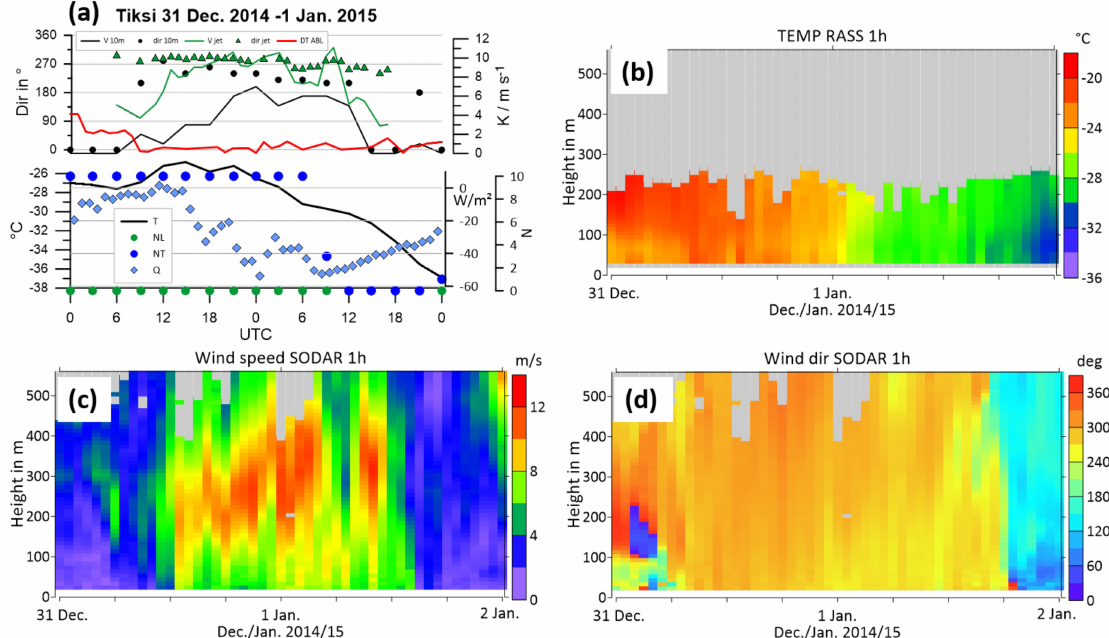
Figure 13. ( a ) Observations for 31 December 2014 and 1 January 2015. Lower panel: time series of 1-hourly measurements of net radiation (Q, light blue diamonds), and 3-hourly measurements of 2 m-temperature (T) as well as observations of cloudiness in 1/10 (total NT, blue dots, and low clouds, green dots); upper panel: 10 m-wind speed (black line) and direction (black dots), jet speed (green line) and direction (green triangles), and temperature difference between 200 and 40 m (red line, scale as for wind speed). ( b )–( d ) Time-height cross-sections from SODAR/RASS data of the ( b ) temperature, ( c ) wind speed, and ( d ) wind direction from 31 December 2014 to 1 January 2015. SODAR/RASS data are shown as pixels (not interpolated), missing data are grey. All times are in